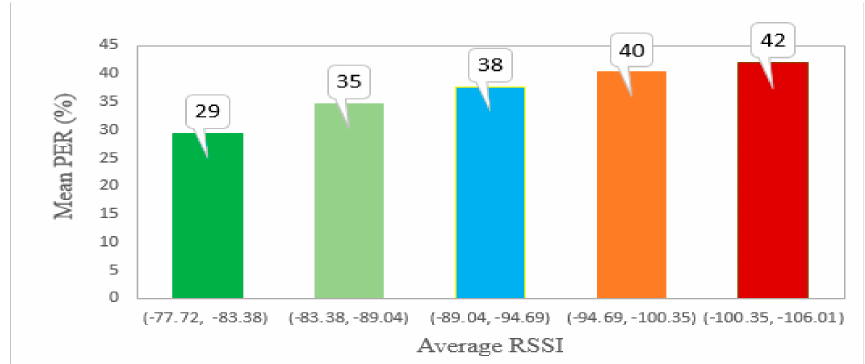
Figure 10. The e ff ect of the signal-to-noise ratio and received radio signal strength on the packet error rate.